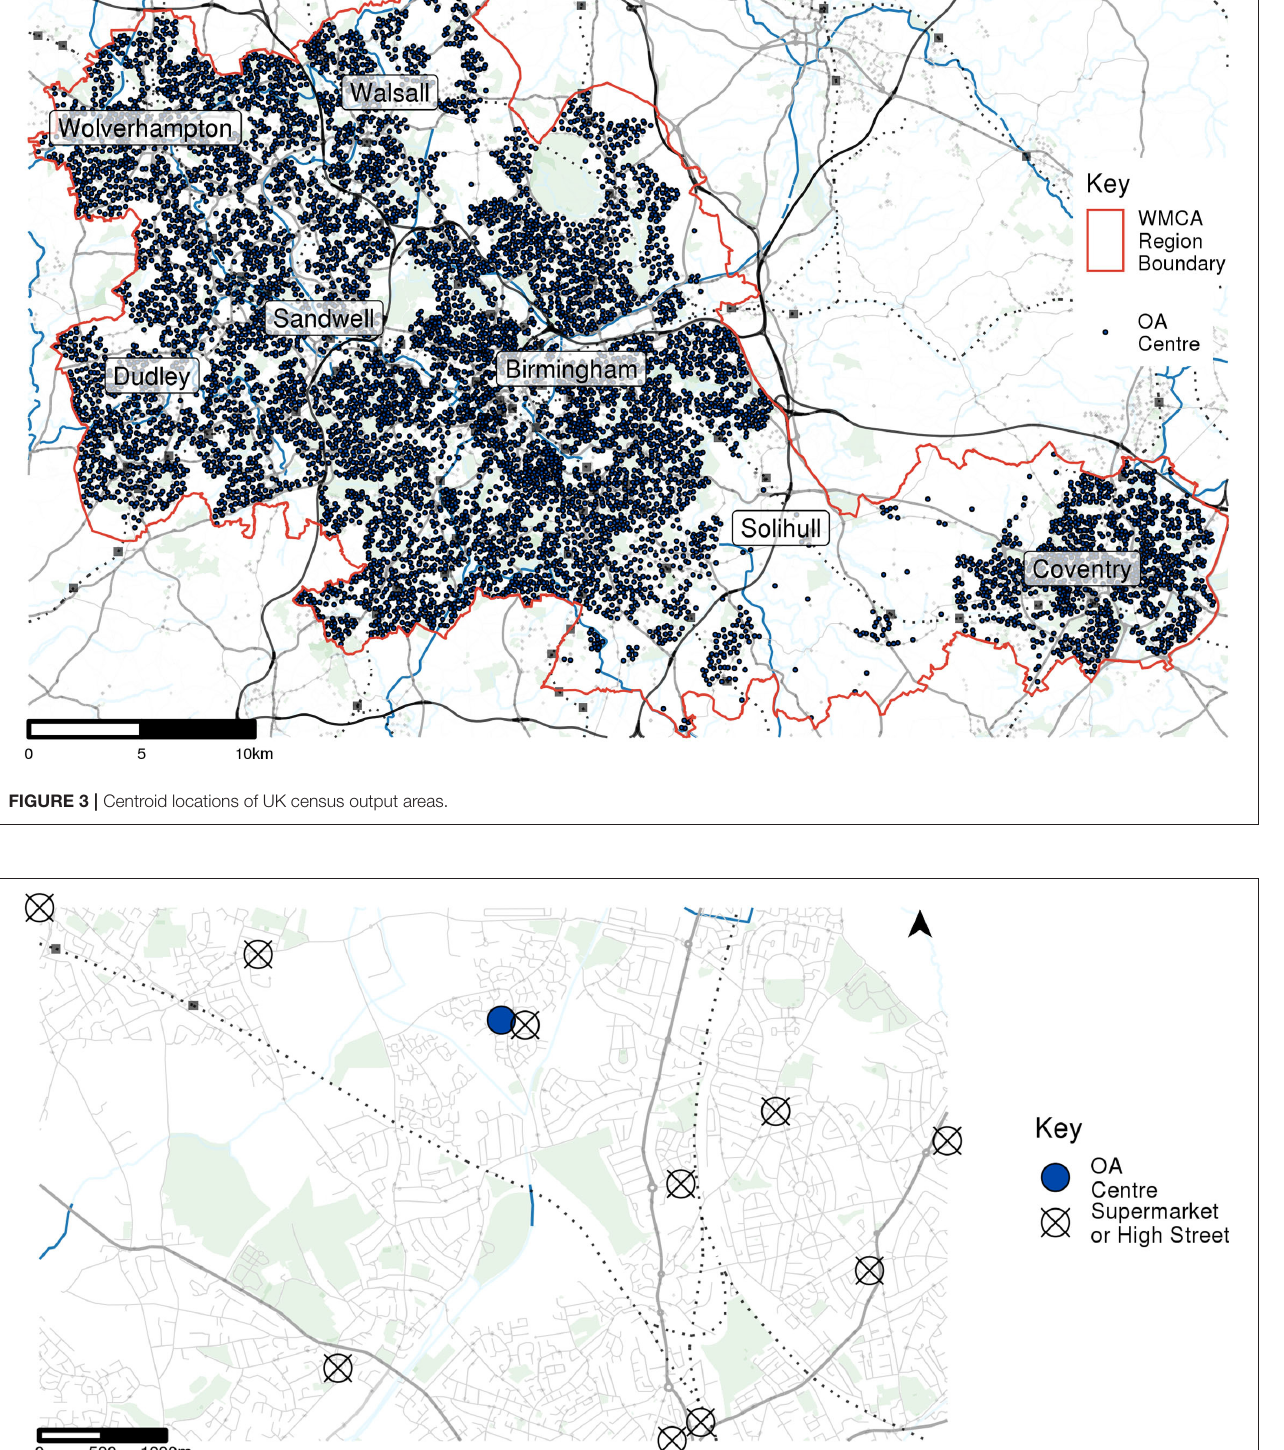
Frontiers in Big Data |